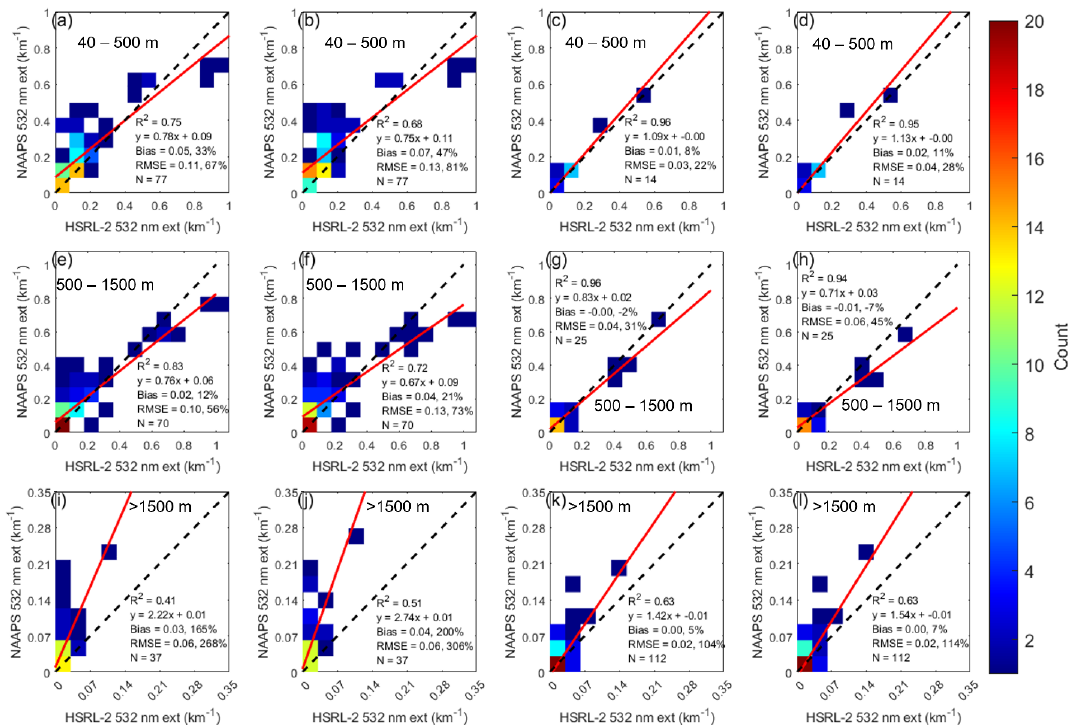
Figure 6. Same as Fig. 4 except when NAAPS-RA either (i) underestimated extinction and overestimated RH or (ii) overestimated extinction and underestimated RH. Linear fits are indicated with red lines, 1 : 1 lines are shown as dotted lines, and the color bar shows the number of points falling in each bin. Where bias and RMSE are reported, the first and second numbers are the absolute and relative values,